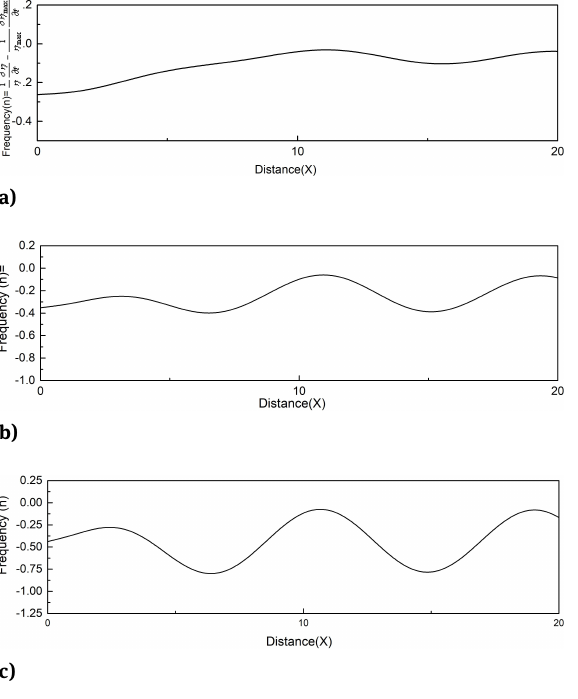
Fig. 5: Comparison between full numerical wave number of ˆ (cid:96) = 0.75 and three roughness. Parameters β −3 , 3.3 × 10 −2 with 1 = 0, 3.3 × 10 fixed values of M . ( from top to bottom) 0 = 0.3,B =0.02 and β = 2